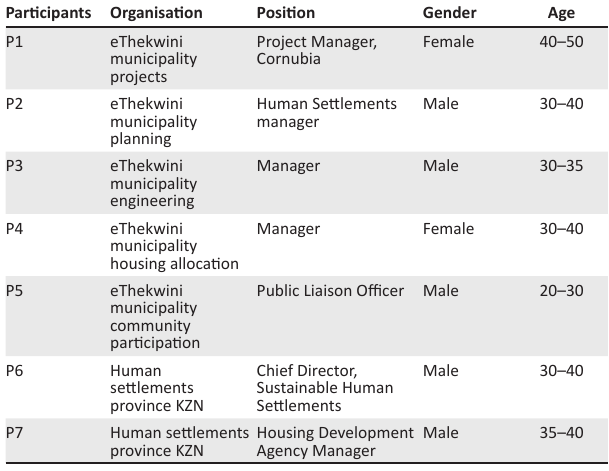
TABLE 1: Representation from officials.